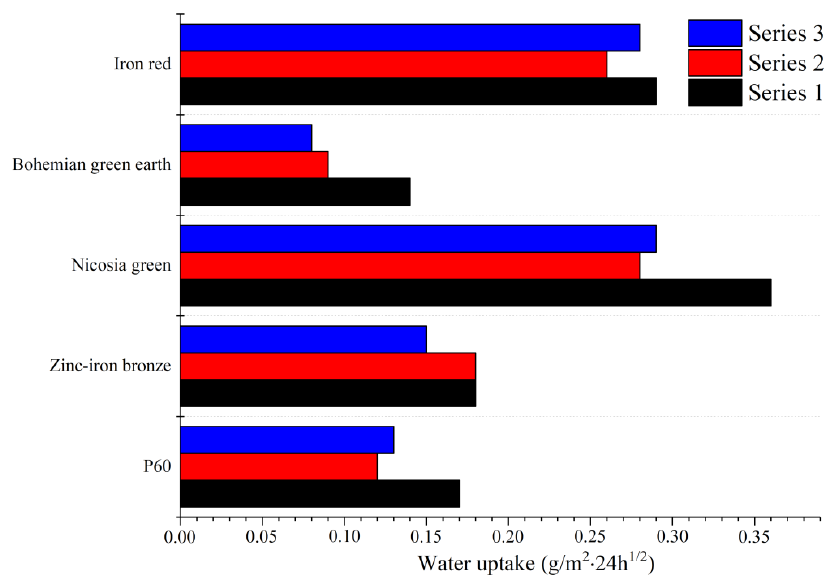
Figure 3. Water uptake after 24 h.